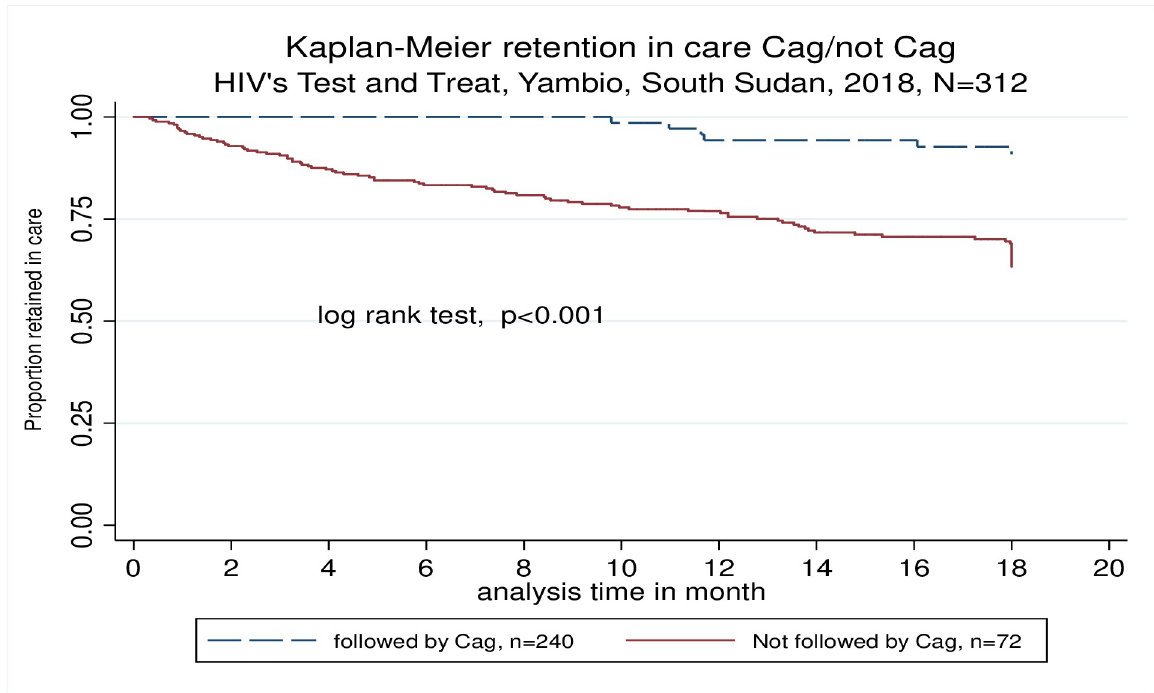
Fig 6. Kaplan-Meier RIC for patients under CAGs compared to patients under regular follow up.